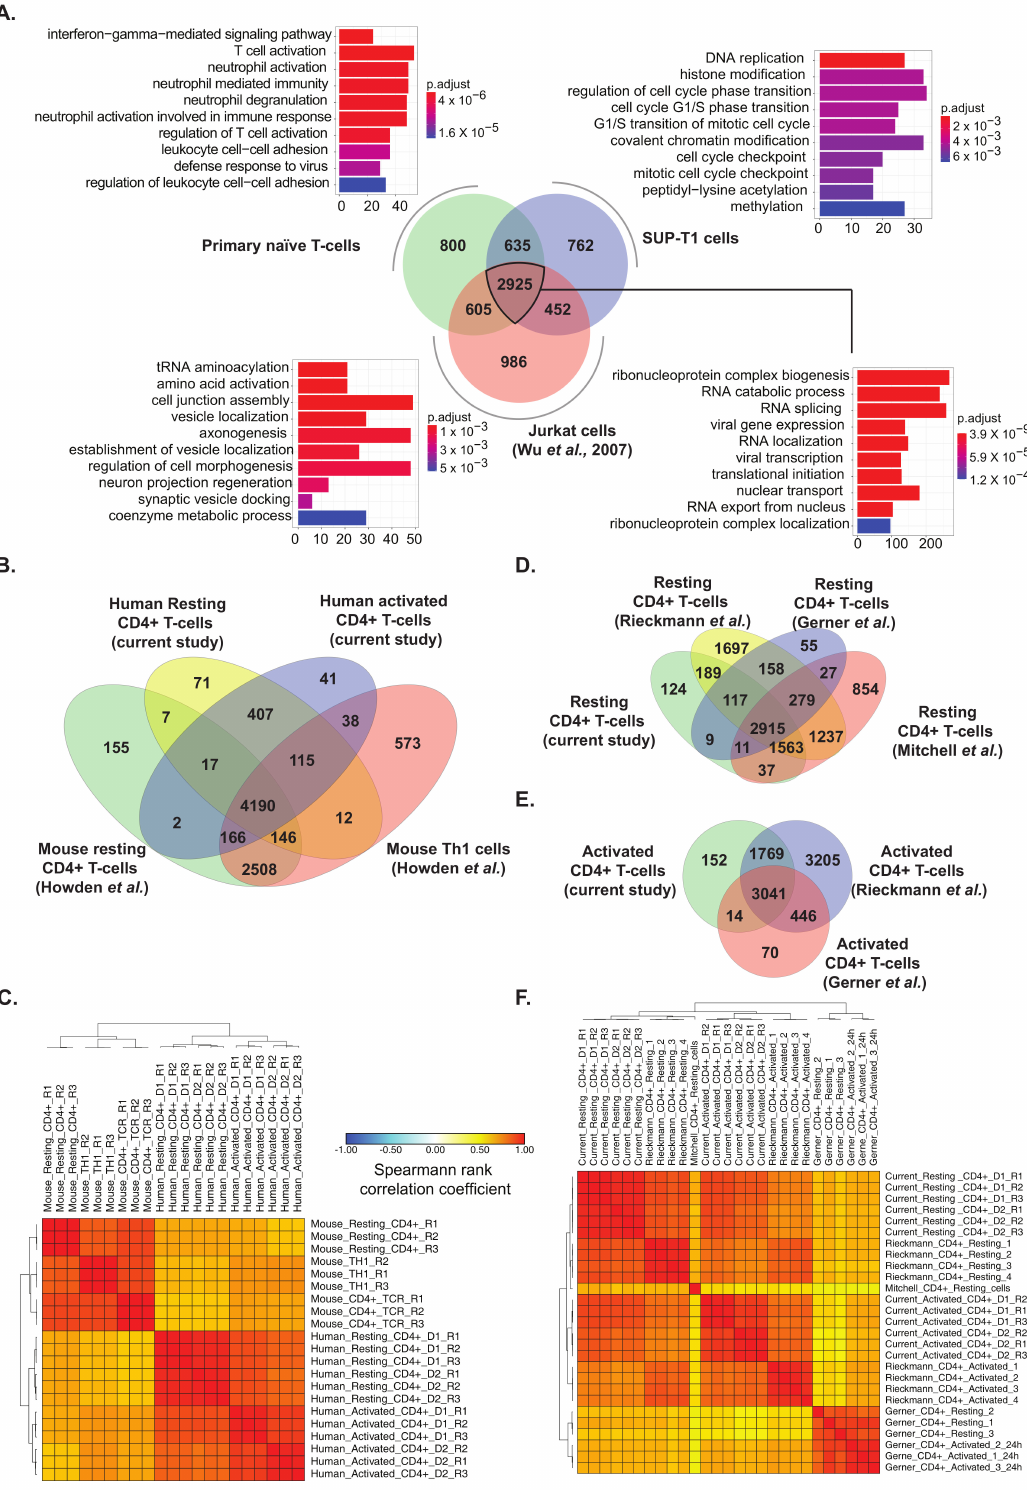
Figure 6. ( A ) Comparison between proteomic profiles of primary resting CD4+ T cells, SUP-T1 cells and Jurkat cells (Wu et al., 2007) and Gene ontology-based classification of biological processes of common proteins and proteins distinct to each cell type ( B ) Comparison of identified proteins and ( C ). Correlation matrix between previously published dataset on mouse (Howden et al.) and human CD4+ T cells (current study). Comparison of lists of identified proteins with previous studies on ( D ) Resting and ( E ) Activated human CD4+ T cells. ( F ) Correlation matrix for proteomic profiles of resting and activated CD4+ T cells from the current study, and previously published studies including Rieckmann et al., Gerner et al., and Mitchell et